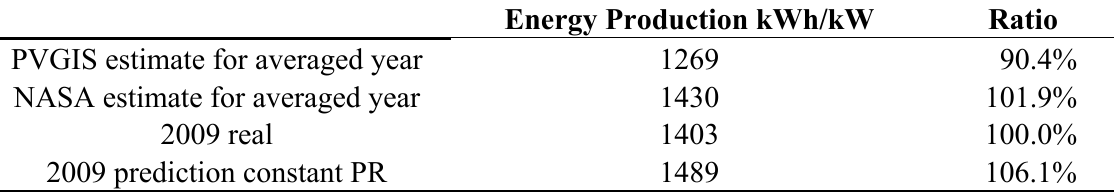
Table 1. Annual EP estimates using PVGIS and NASA for an average year, real EP in 2009, and predicted EP in 2009 using constant PR, at the Villafranca CPV